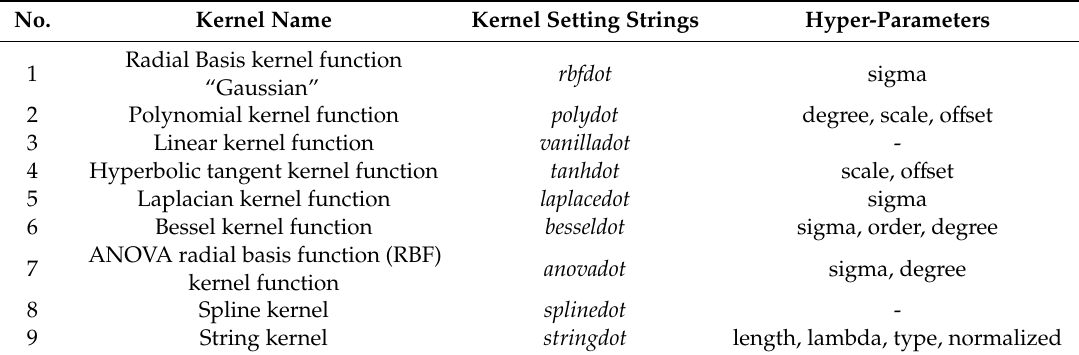
Table 5. Summary of kernel functions o ff ered by the “kernlab” package.